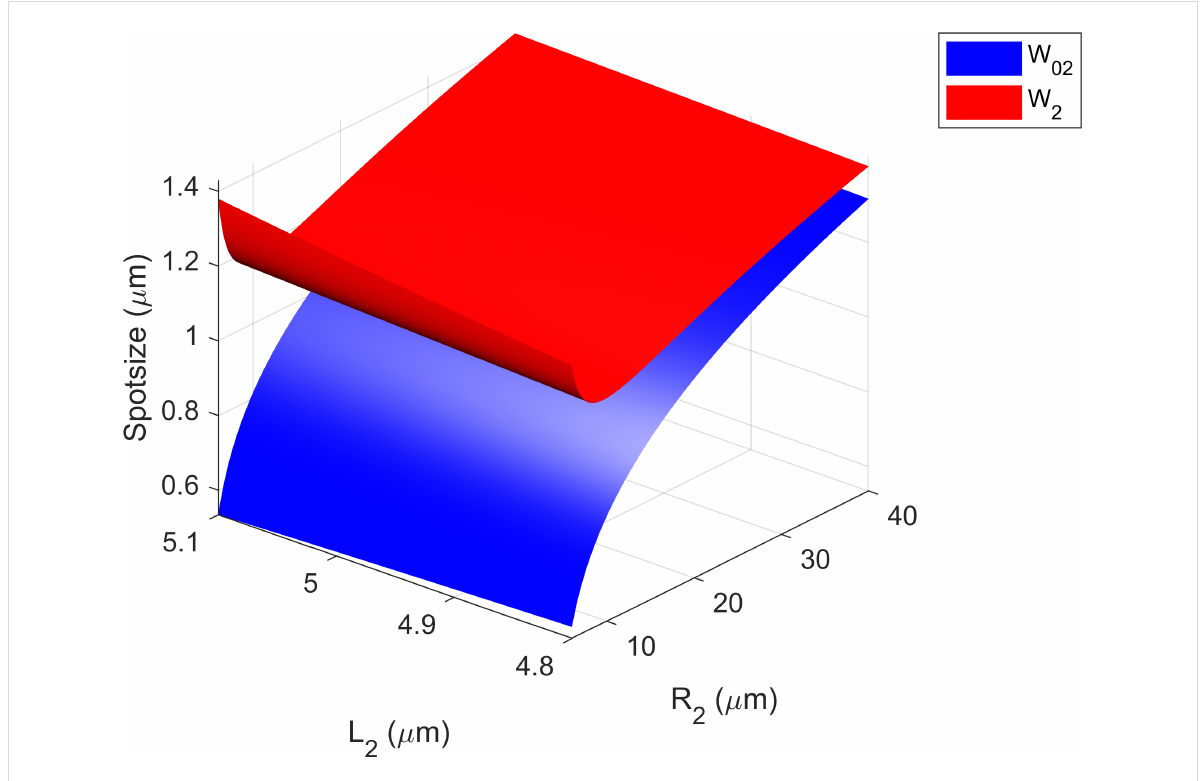
Figure 4: Spotsizes W 02 and W 2 for different values of R 2 and L 2 .